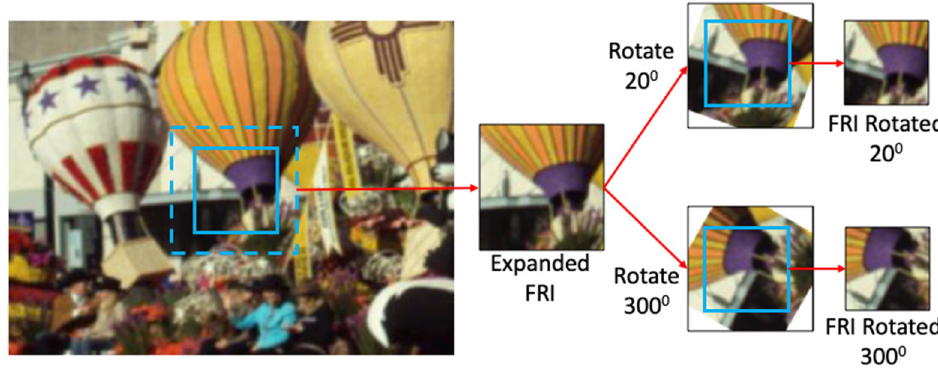
Figure 4. Rotation invariance operation.